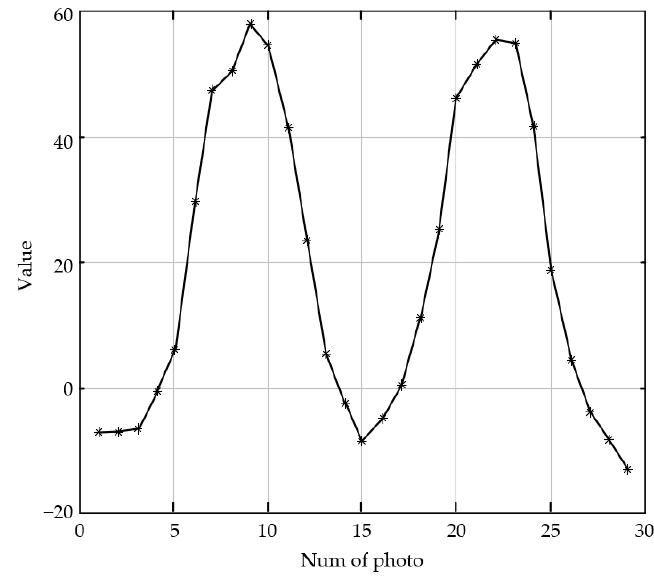
Figure 8. Predictive scores of the dual-peak defocused image sequence.